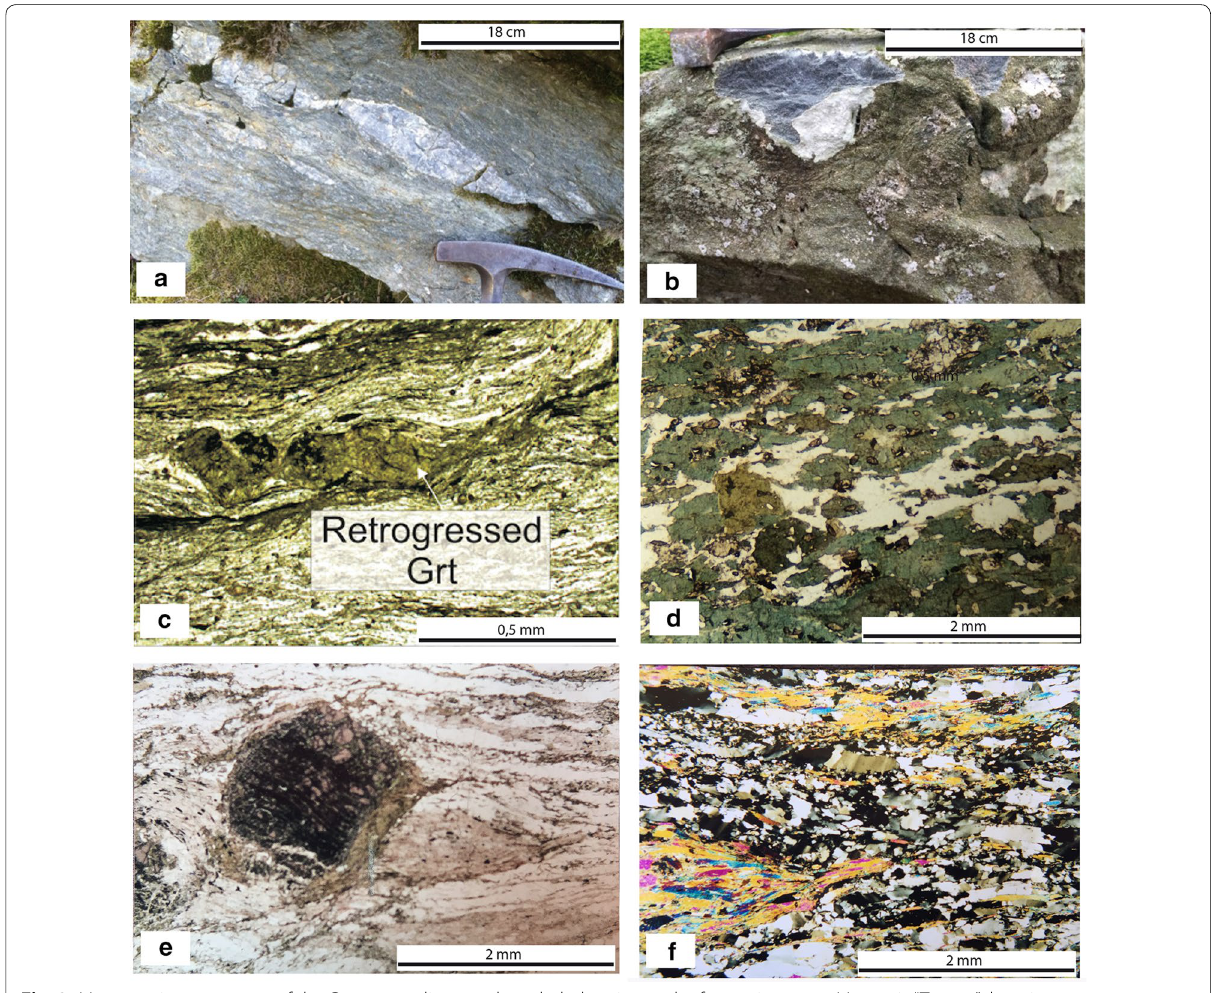
Fig. 3 Mesoscopic appearence of the Cerreto medium grade rocks belonging to the former inner pre-Mesozoic “Tuscan” domain a mylonitic micaschist; b Morb-derived amphibolite. Plane-polarized light microphotographs of c micaschist with fractured and retrogressed garnet porphyroclast (from Lo Po’ et al. 2017) and d amphibolites (details in Molli et al. 2002; Lo Po’ et al. 2017); e mylonitic micaschist and f quartz-feldspatic mylonites from Pontremoli well (former pre-Mesozoic external "Tuscan"